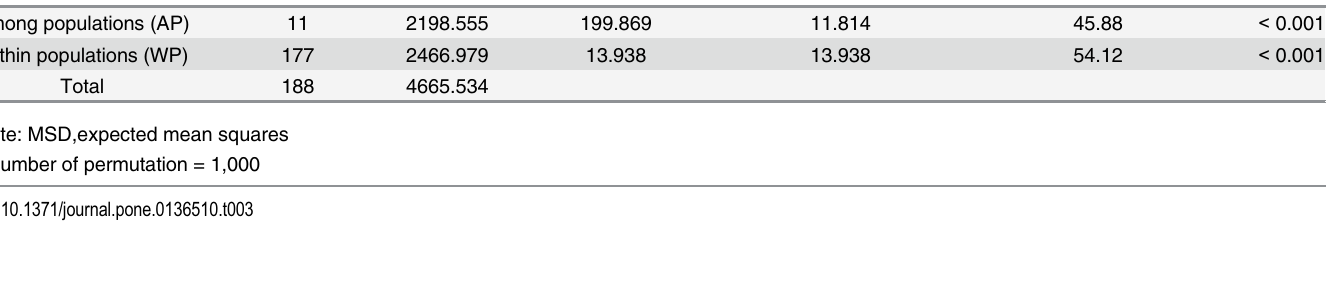
natural D . kaki var. silverstris Mak populations and that species variation was also affected within the population. The SCoT data were analyzed through PCoA. The accumulative contri- bution rate of the first and second coordinates was 49.96%, indicated the main original infor- mation. The 189 individuals in the two-dimension diagram occupy a large space and were widely distributed, showed that its genetic background was broad and extremely diverse. Some populations overlap and interact, showed that the permeation of genes and communication took place among the natural D . kaki var. silverstris Mak populations (S5 Fig). The geographic distance and genetic distance between the wild D . kaki var. silverstris Mak populations were calculated through Mantel test analysis, results showed that genetic distance had positive rela- tionship with geographical distance ( r = 0.5559; S5 Table). A dendrogram was constructed based on the results of Nei ’ s genetic distance using the UPGMA method (Fig 4). Twelve natural D . kaki var. silverstris Mak populations in Guangxi were divided into two clusters at similarity coefficient of 0.19. One cluster contained popula- tions from Longlin, Xilin, Tianlin, Youjiang, and Leye; whereas the other contained popula- tions from Quanzhou, Huanjiang, Zhongshan, Luzhai, Wuxuan, Qintang, and Hengxian. The genetic distance between the Wuxuan and Qintang populations was 0.091, and the genetic rela- tionship was the closest among the populations. However, the genetic distance between the Youjiang and Quanzhou populations was 0.292, showed the farthest genetic distance. The clus- tering result supported the distribution of the two principal coordinates by PCoA. Table 3. Analysis of molecular variance (AMOVA) within and among natural D . kaki var. silvestris Mak. populations. Source of variance d.f SSD MSD Variance component Percentage(%) P * Among populations (AP) < 0.001 Within populations (WP) <